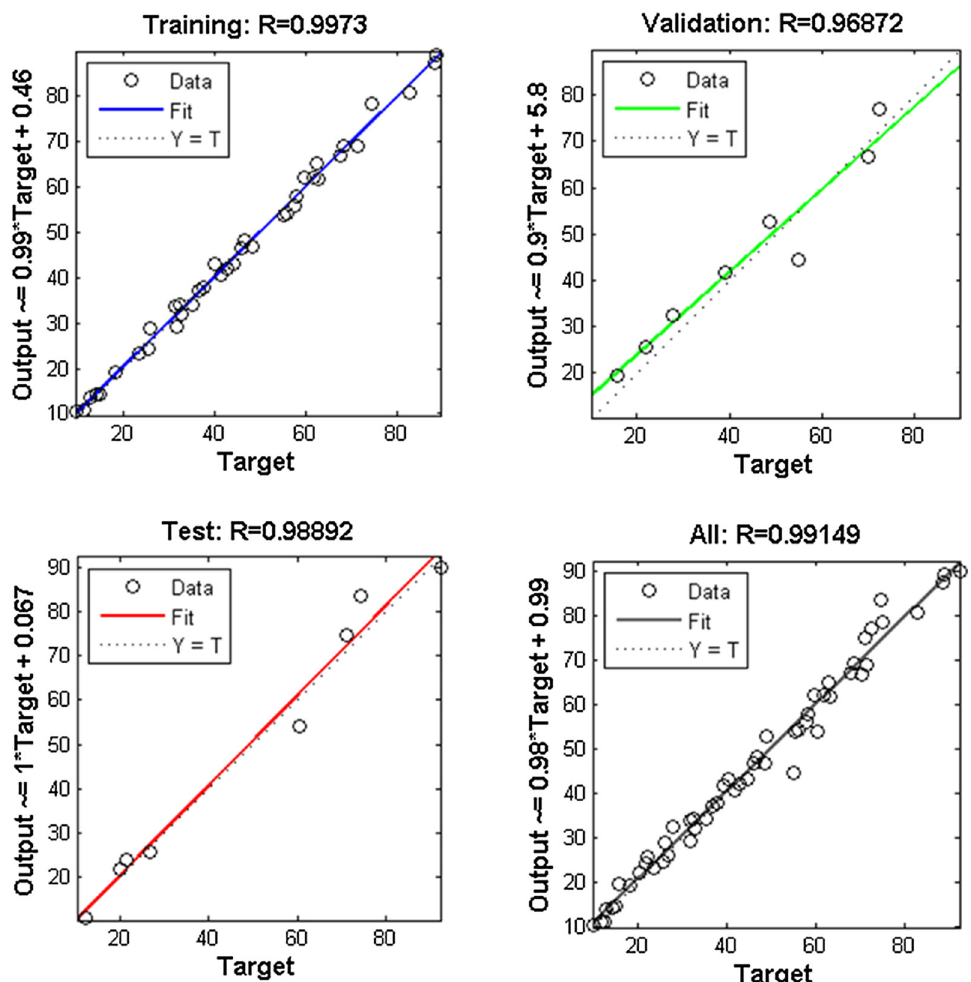
Fig. 1 Trained network for CO conversion